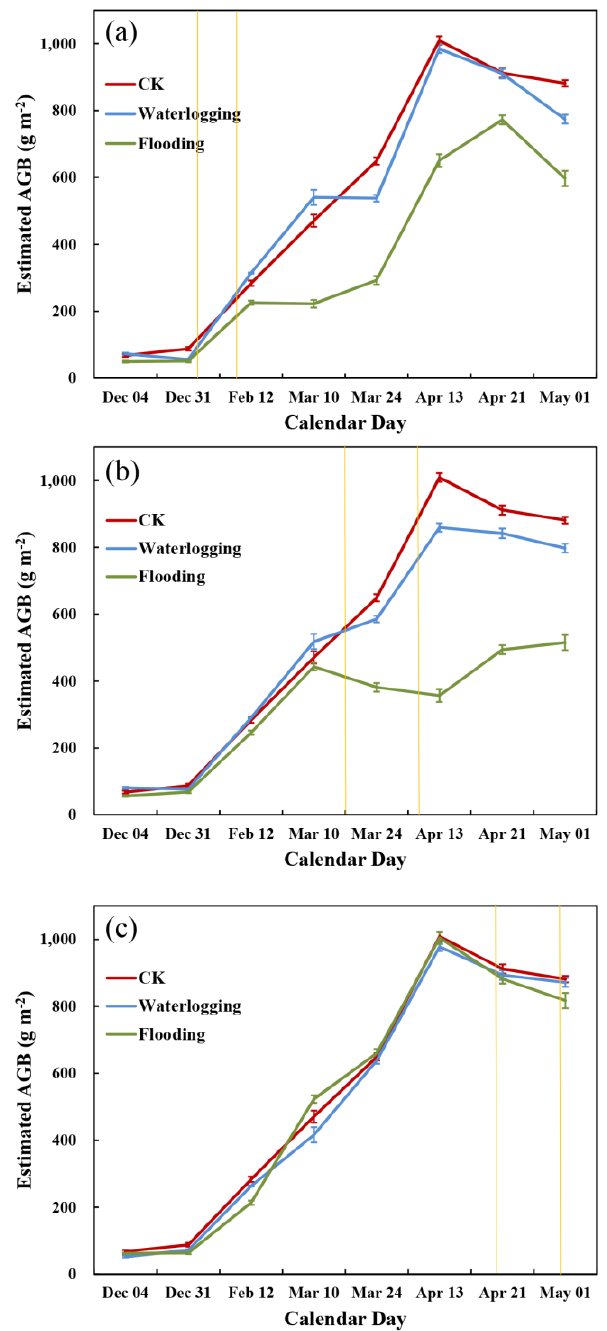
Figure 4. Variation of the estimated AGB for different soil water content treatments from 2014 to 2015 growth stages. ( a – c ) represents the soil water content treatments imposed at seedling stage, flowering stage, and podding stage, respectively. The shallow orange vertical lines mean the date of waterlogging treatments imposed at three growth stages, respectively.